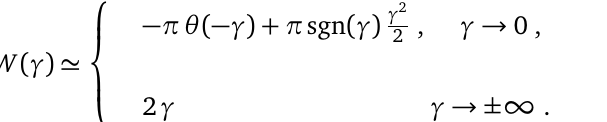
is continuous. Note eff ( x ) is continuous as a eff 1